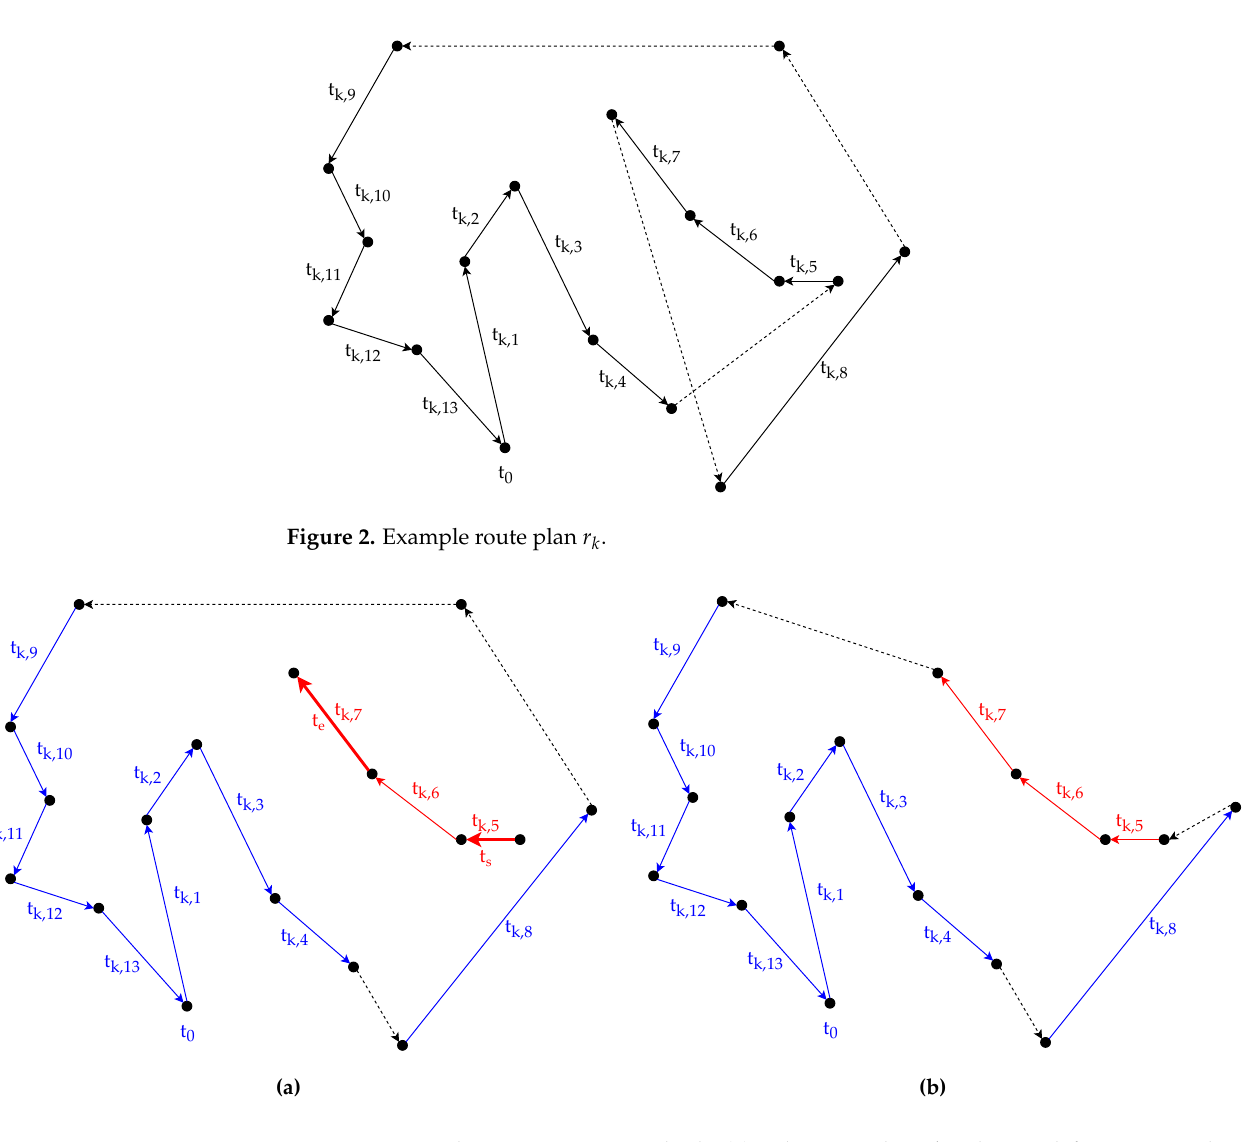
Figure 3. Greedy reconnection method: ( a ) sub-route plan r ∗ ( b ) sub-route plan r ∗ connected to the route plan r # k